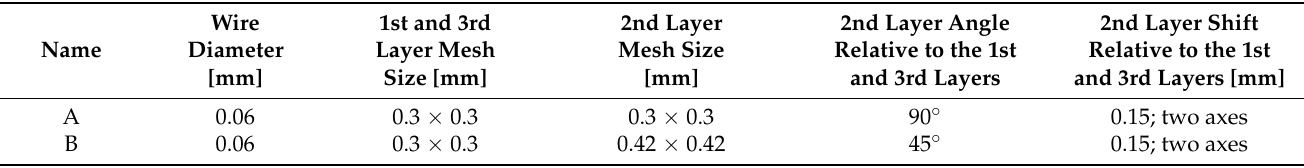
Table 2. Differences between investigated